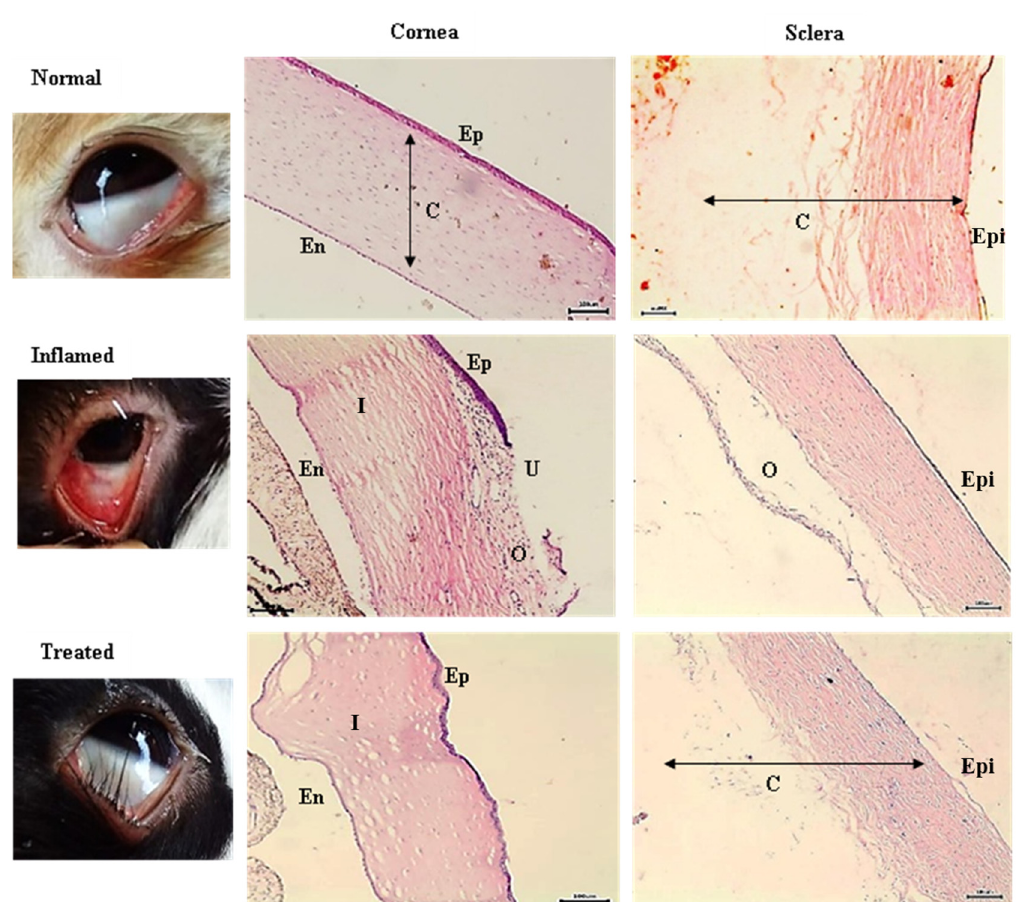
Figure 6. Light microscopy images of representative cornea and sclera of rabbit, before and after treatment using MLX-CS-NPs eye drop dispersion. Abbreviations; Ep, epithelium; En, endothelium; C, connective tissue; Epi, episclera; U, ulcer; O, oedema; I, inflammatory cells. Abbreviations: MLX-CS-NPs; MLX/chitosan nanoparticles.